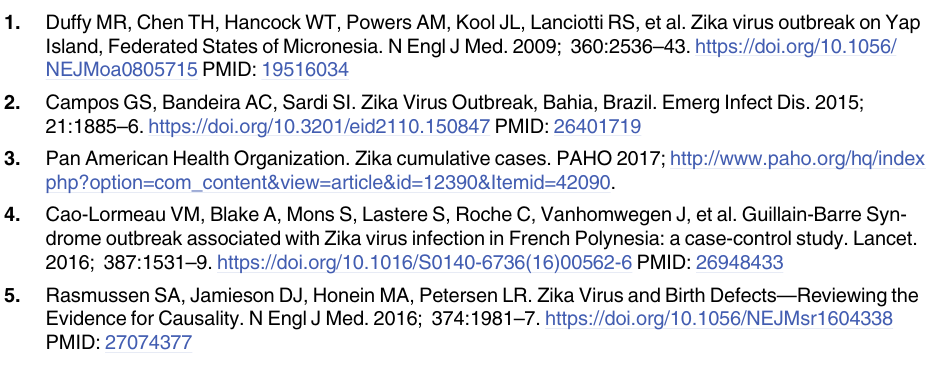
S1 Table. The complete LFRET result listing. This table contains the LFRET test results for all samples in all of the assay variants. S2 Table. IgM ELISA and acute-LFRET. This table contains a comparison of the absorbance values and test outcomes of Euroimmun IgM ELISA against the acute-LFRET results. S3 Table. IgG ELISA and immunity-LFRET. This table contains a comparison of the absor- bance values and test outcomes of Euroimmun IgG ELISA against the immunity-LFRET